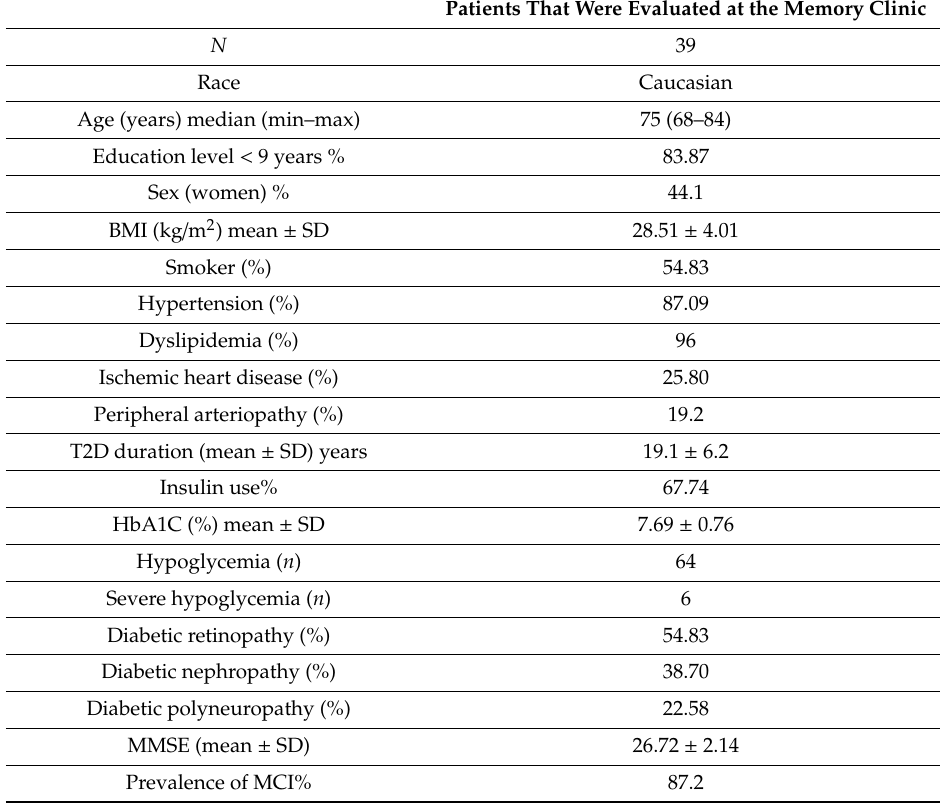
Table 2. Characteristics of the patients that were performed a complete neuropsychological evaluation 2. at the memory